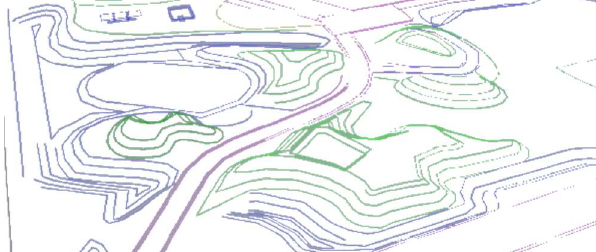
Figure 4: The 2.5D data from Gentbrugge needed for the GNSS- excavator.